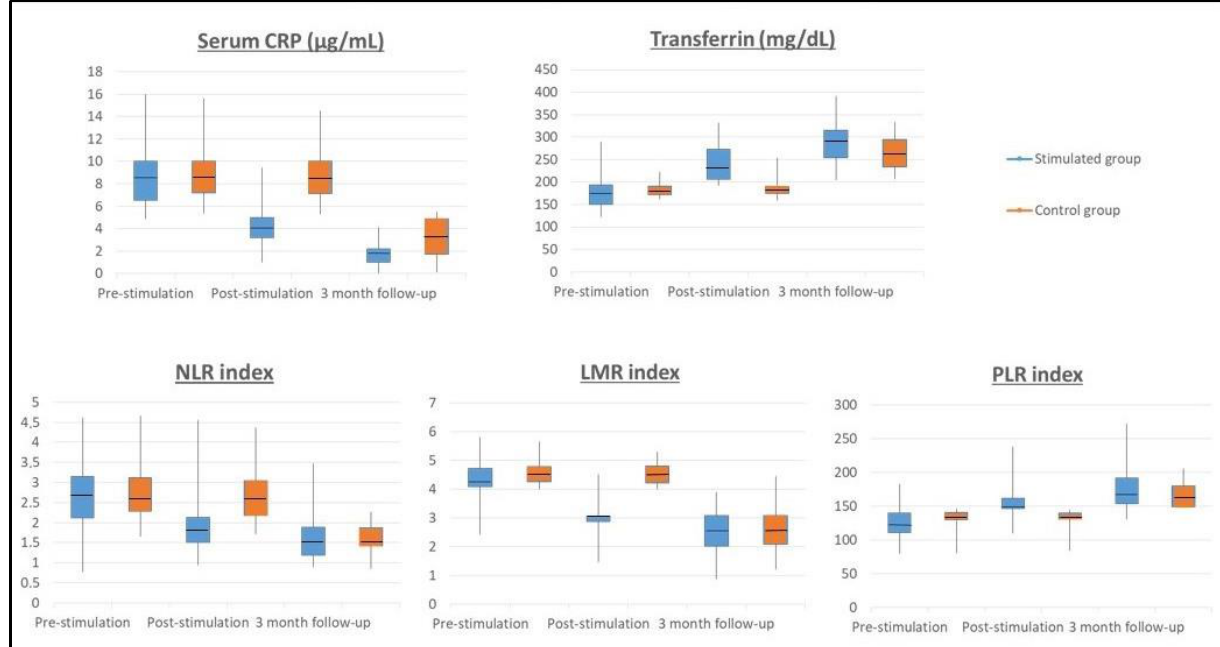
Figure 2. Inflammatory biomarkers throughout the study. Probiotics stimulation changes in serological biomarkers. The levels of CRP (C-reactive protein), NLR (neutrophil-to-lymphocyte ratio), LMR (lymphocyte-to-monocyte ratio), PLR (platelet-to-lymphocyte ratio), and transferrin were modified by probiotic consumption after the stimulation phase ( p < 0.001). The levels of CRP, NLR, LMR, PLR, and transferrin were similar after 3-month follow-up.